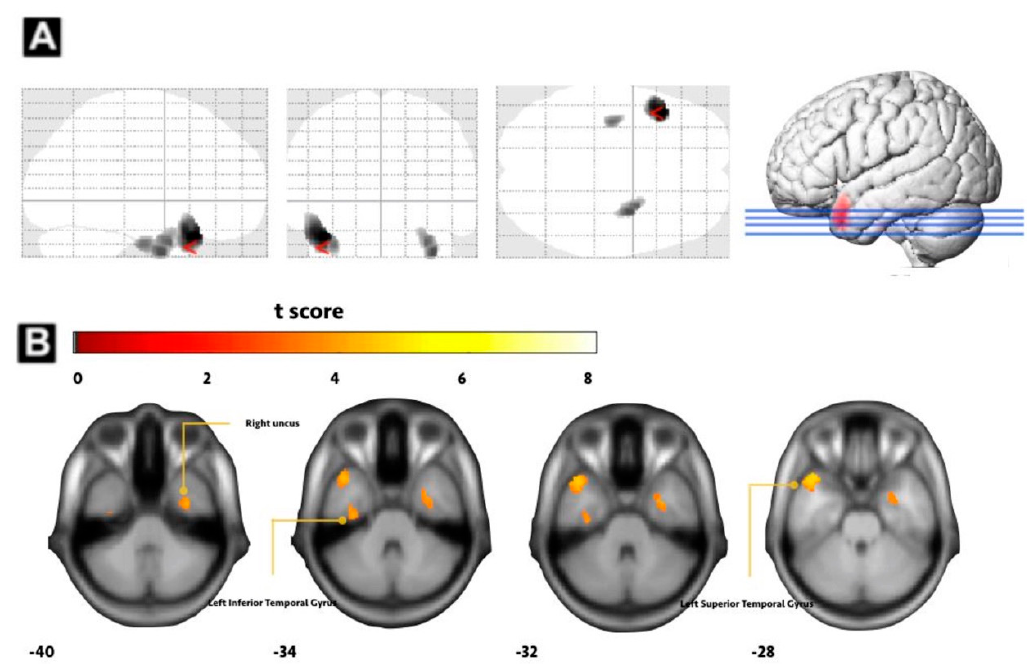
Figure 1. Voxel-based morphometry analysis between PD group and NC group. ( A ) Smaller gray matter volume (GMV) in PD group versus normal control (NC) group in the right uncus. ( B ) Left inferior temporal gyrus and left superior temporal gyrus (FWE corrected p -value < 0.001). Table 2. Regions of statistically significant reduced gray matter volume (GMV) in early PD compared to healthy control group.